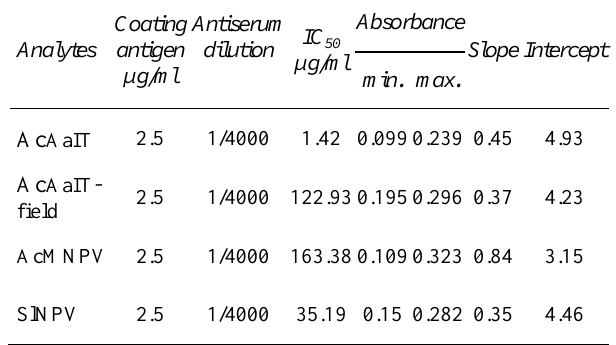
Table 2: Selected competitive ELISA screening data against AcAaIT. AcAaIT polyhedrin was used as the coating antigen.